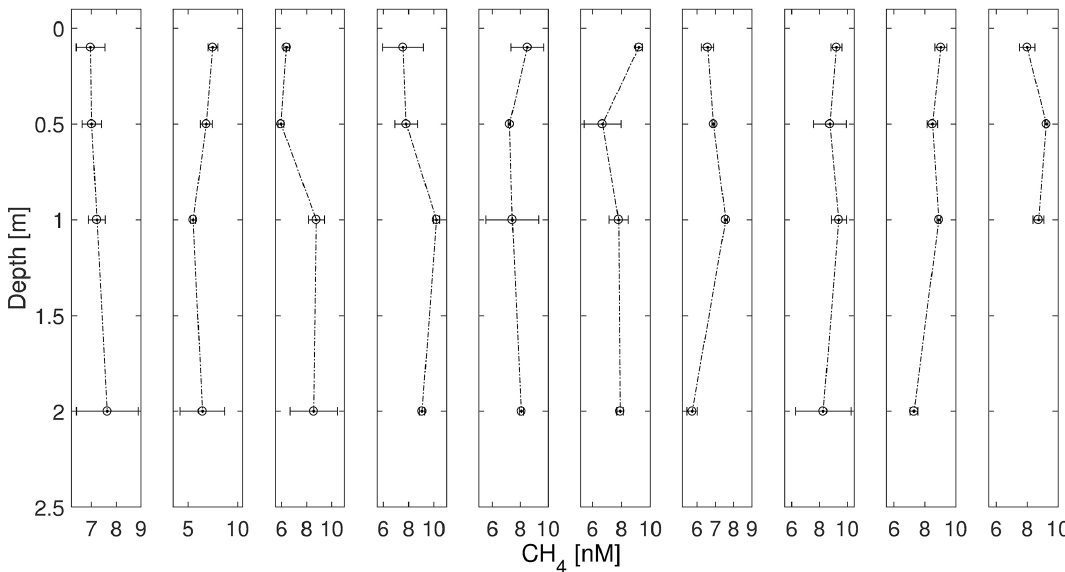
Figure 7. Near-surface profiles of CH 4 with sampling from the zodiac and UW sampling from the ship ( ∼ 2m) during AL 516 in Septem- ber 2018. The time lag between zodiac sampling and UW sampling was max 1h. All samplings were conducted in the morning ( ∼ 06:00 local time). Error bars indicate 95% confidence interval (CI), calculated from triplicate